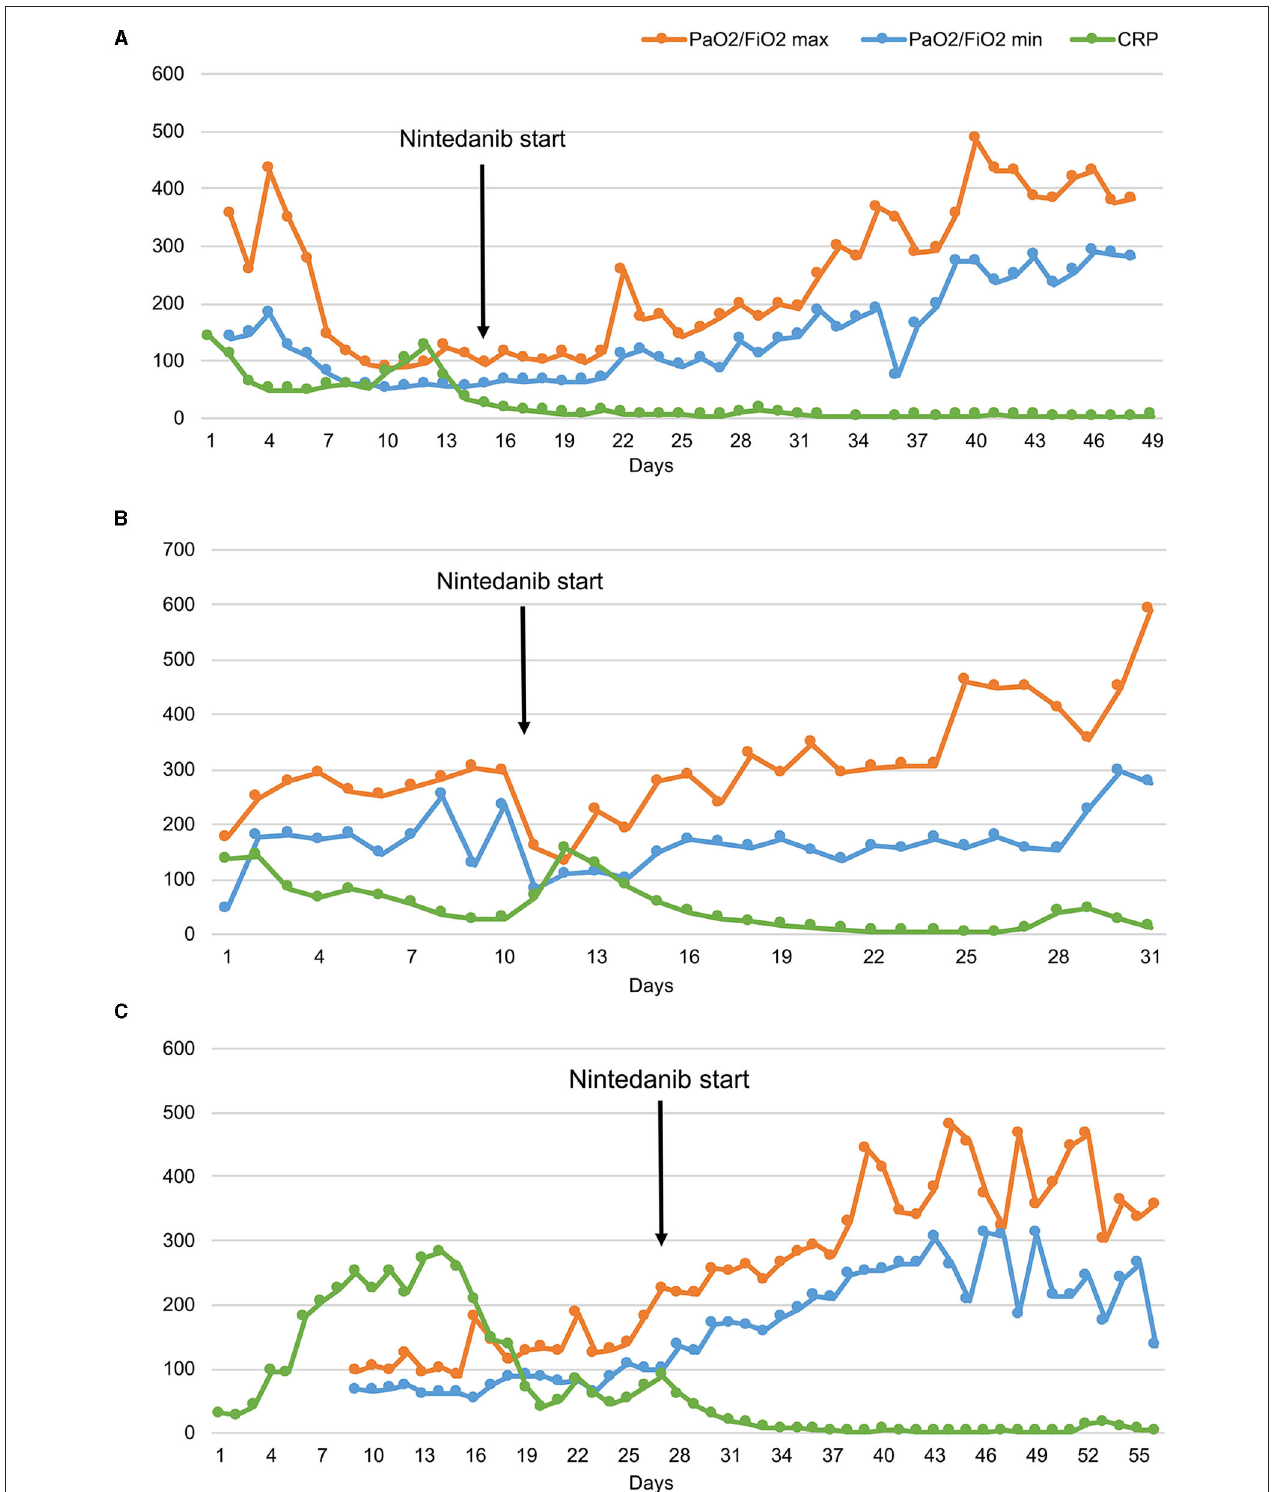
FIGURE 3 | The ratio of partial pressure arterial oxygen to fractional inspired oxygen (PaO 2 /FiO 2) and C reactive protein (CRP) levels over time in three patients (A–C) . Despite daily variations in minimum and maximum PaO 2 /FiO 2 values, the trend shows progressive respiratory function improvements since the start of nintedanib in all